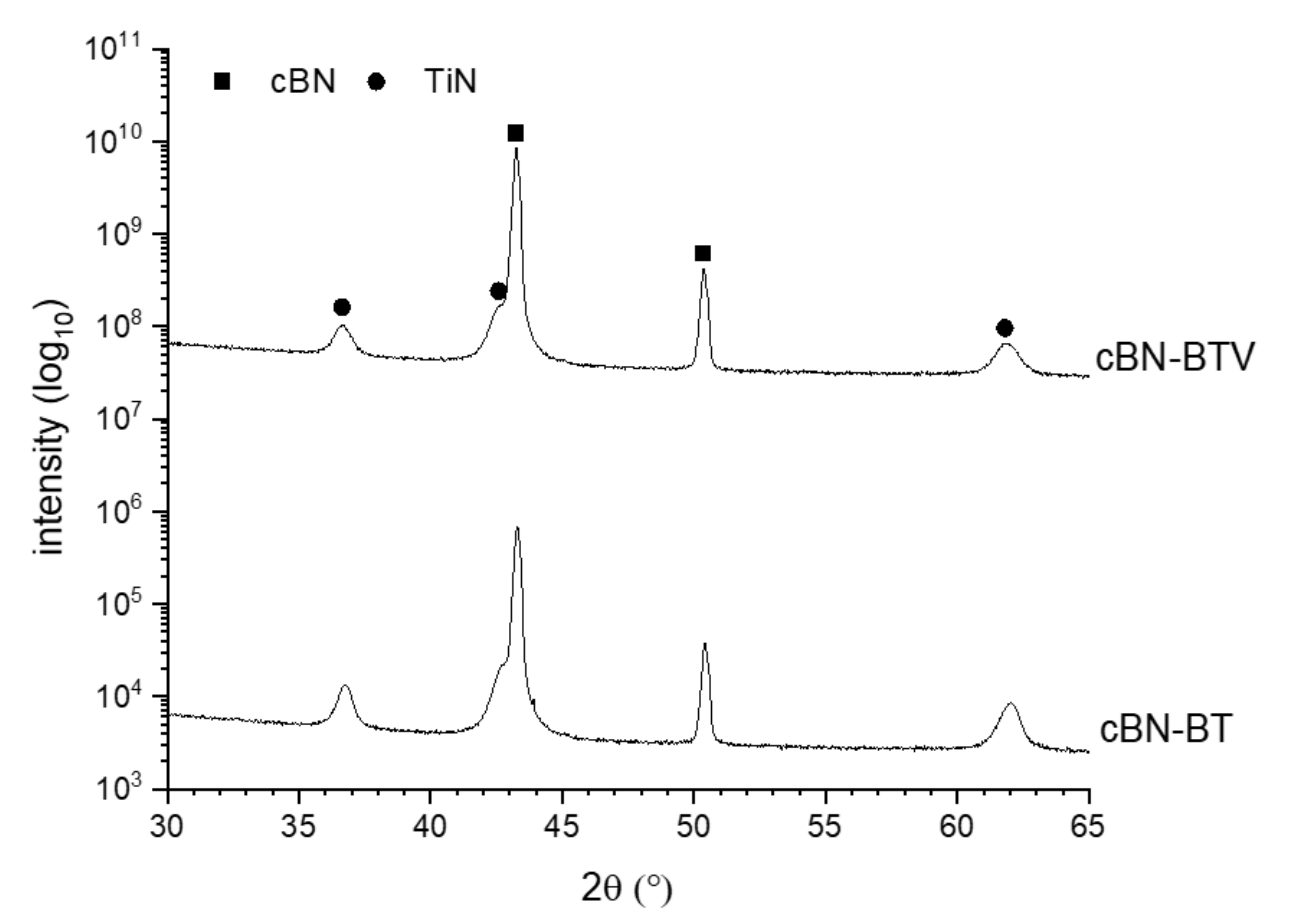
5 of 19 Table 1. Properties of the used cubic boron nitride (cBN) powders and TiN coated cBN powders regarding oxygen content, metallic impurities, coating content and coating thickness (the TiN content was determined by XRF measurement of Ti and XRD). cBN-Powder Oxygen Content (wt. %)